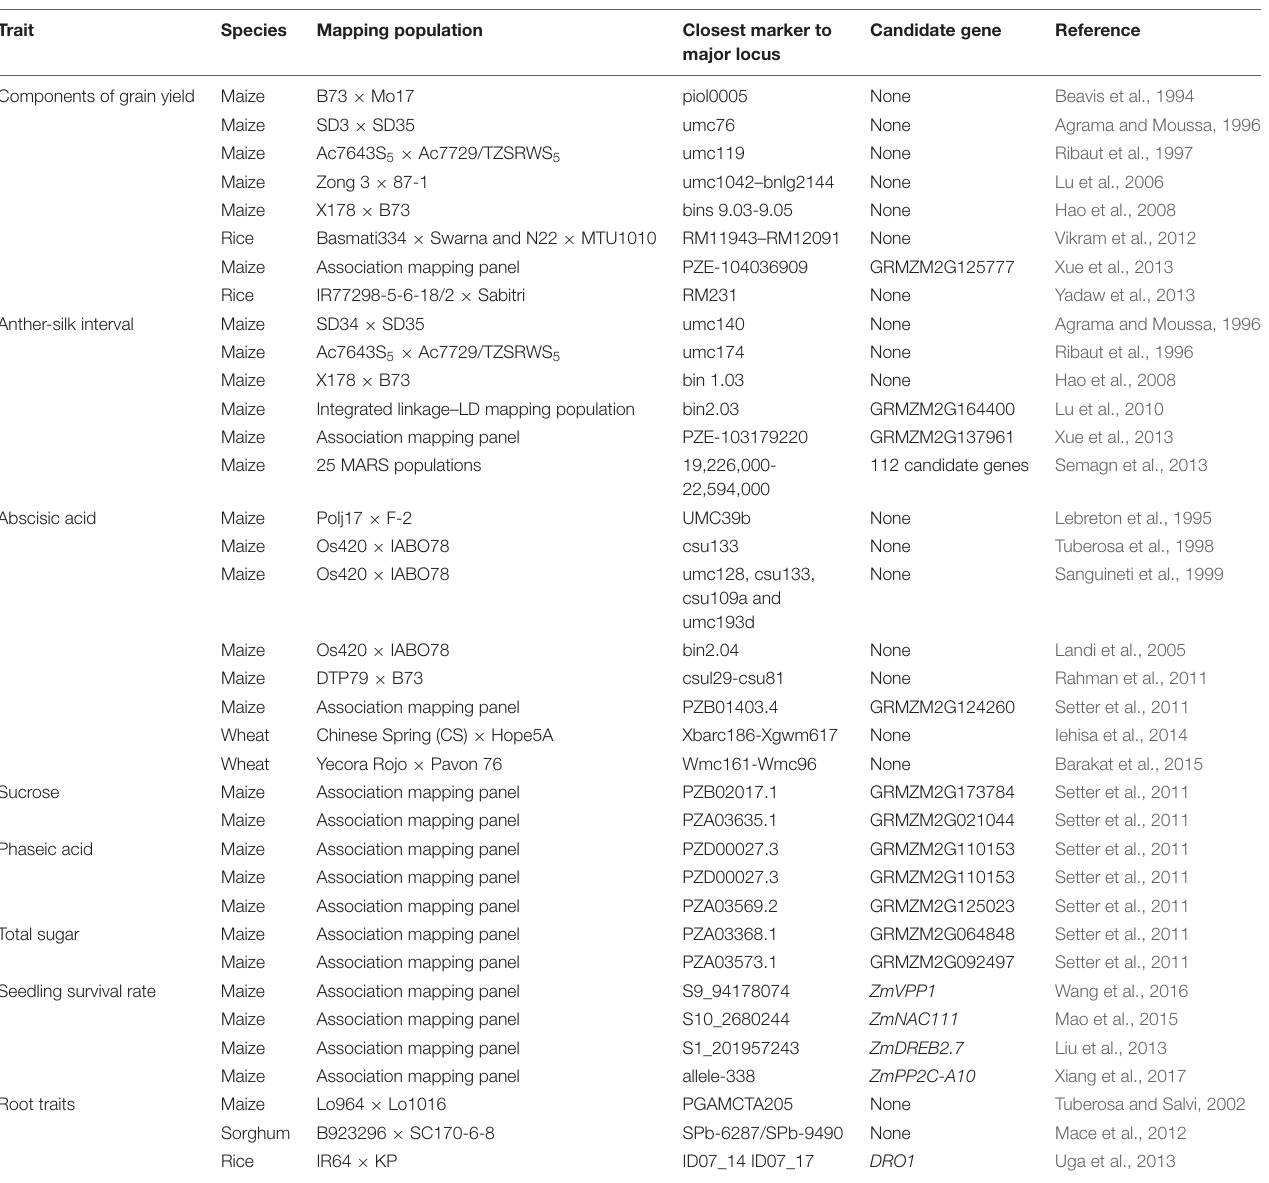
TABLE 1 | Genetic dissction for drought resistance and related traits.